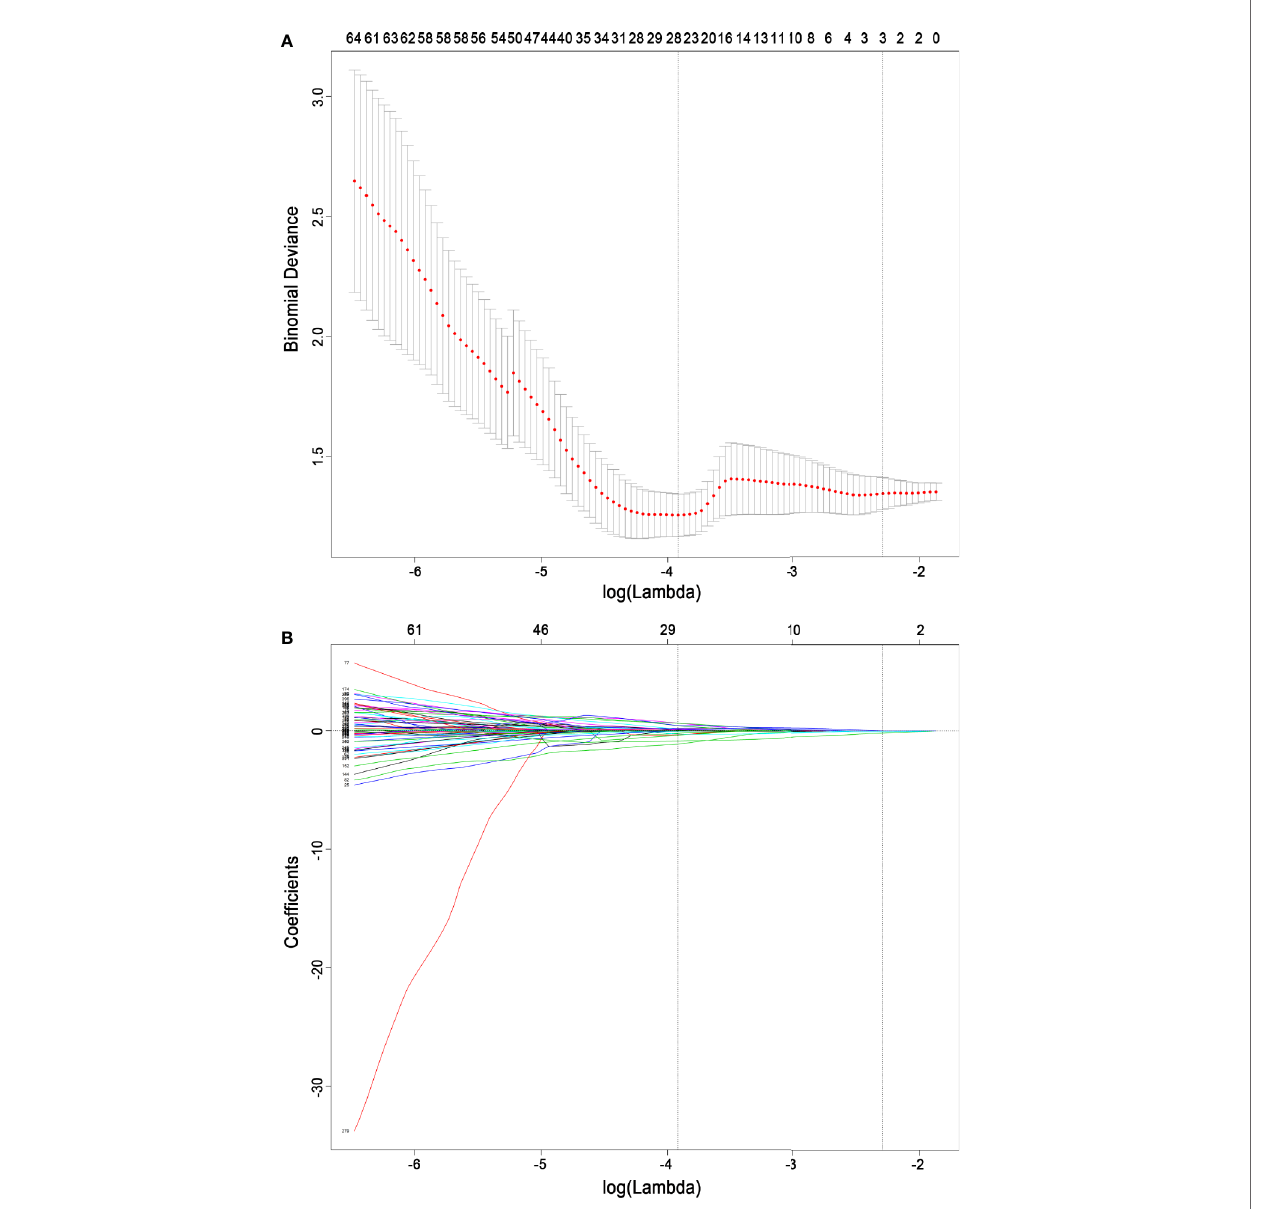
FIGURE 4 | Radiomics feature selection based on the least absolute shrinkage and selection operator binary logistic regression model. (A) Ten-fold cross-validation via minimum criteria was used for tuning the parameter (lambda) in the least absolute shrinkage and selection operator model. The relationship between the binomial deviance and log (lambda) was plotted. The left dotted vertical line was at the optimal lambda value point by using the minimum criteria, and the right line was at the optimal lambda value point by using one standard error of the minimum criteria (the 1-SE criteria). A lambda value of 0.01987634, with log (lambda) − 3.918, was chosen (minimum) according to 10-fold cross-validation. (B) The least absolute shrinkage and selection operator coef fi cient pro fi les of the 396 radiomics features. A coef fi cient pro fi le plot was plotted versus the log (lambda) sequence. A vertical line was drawn at the value selected using 10-fold cross-validation, where the optimal lambda resulted in 26 nonzero coef fi